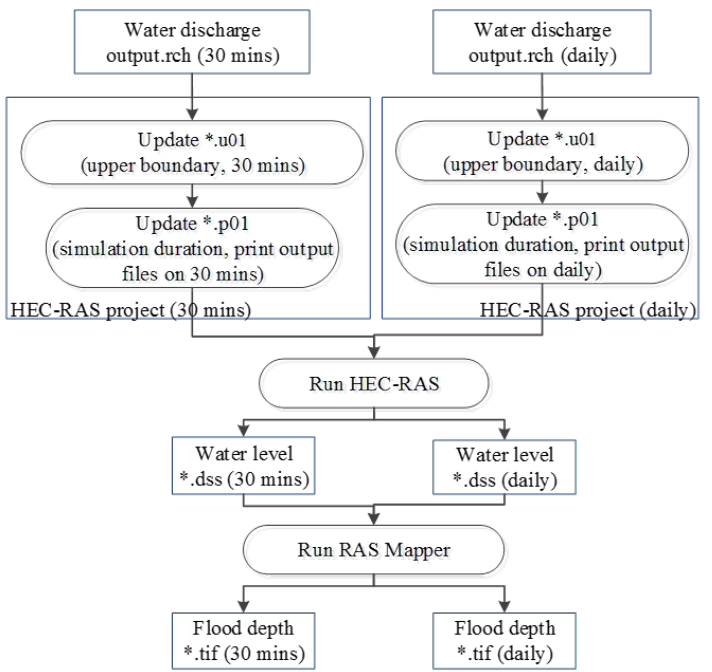
Figure 6. Automated process of water level, flood depth simulation in the Hydrologic Engineering Center’s River Analysis System (HEC–RAS) model.